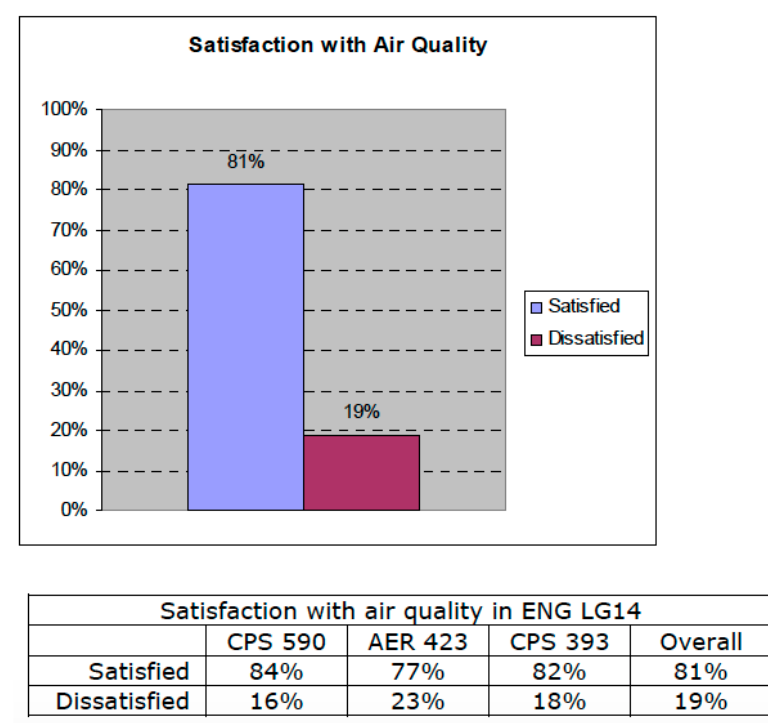
Figure A4. Air Quality Satisfaction Survey Results.